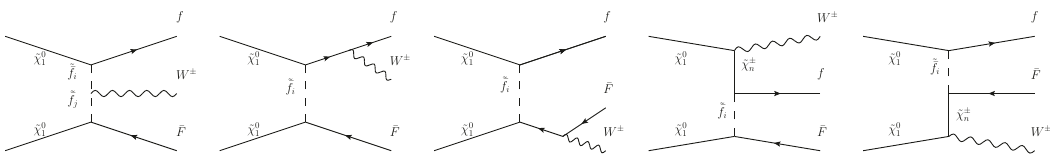
Figure 3 . Same as (cid:12)gure 2, but mediated by s -channel bosons with a mass at the electroweak scale.